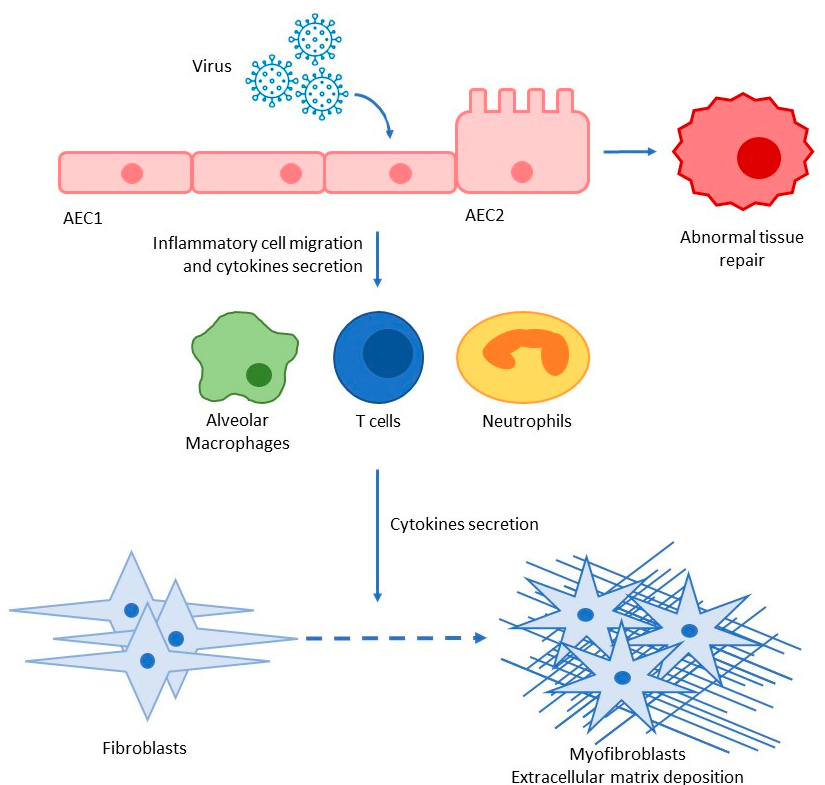
Figure 2. Pro-inflammatory and pro-fibrotic cascade after SARS-CoV-2 infection; AEC alveolar Figure 2. Pro-in fl ammatory and pro- fi brotic cascade after SARS-CoV-2 infection; AEC alveolar epithelial cells type I and epithelial cells type I and II.